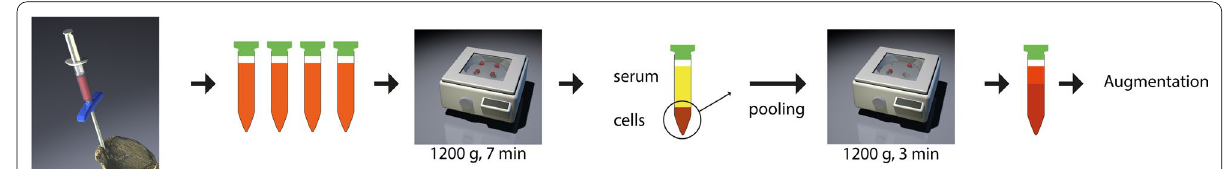
Fig. 2 Schematic drawing of the preparation of enriched bone-marrow aspirate: bone marrow was aspirated with a bone cannula. 2500IE heparin per 20 ml syringe were added and a total of 50–60 ml of bone-marrow aspirate was gained. Centrifugation in 4 tubes at 1200 g for 7 min. Removal of the serum supernatant and pooling of the cell-concentrates in one tube for second centrifugation at 1200 g for 3 min. Removal of the supernatant and approximately ten millilitres of enriched stem cells were gained